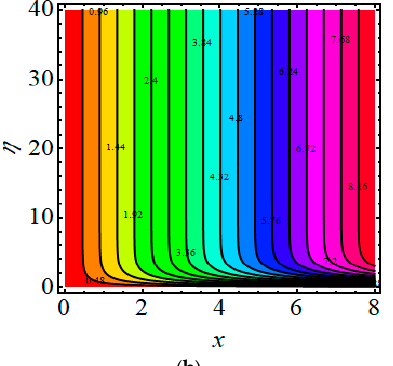
Figure 11. ( a , b ) Streamline for ( a ) β = − 2.5 and ( b ) β = 2.5.